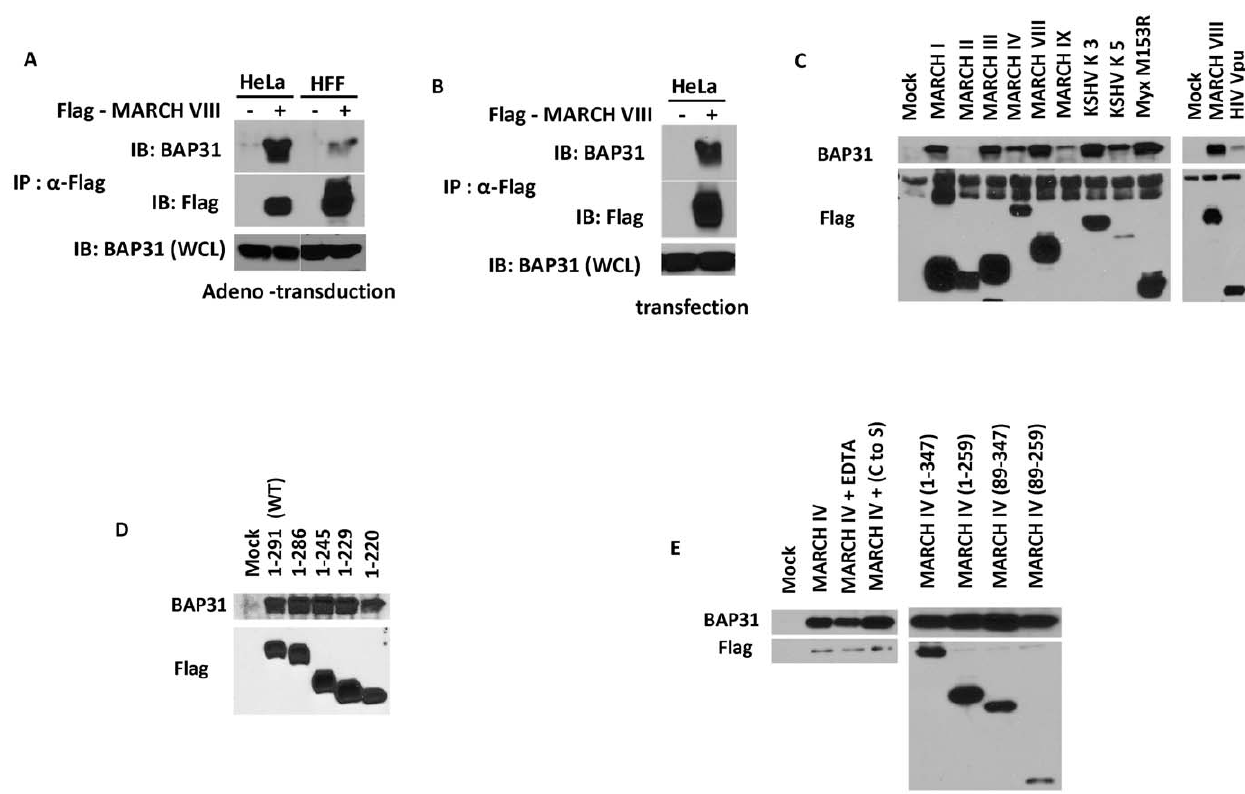
Figure 2. MARCH-VIII interacts with Bap31 through the transmembrane domains. MARCH-VIII C-Flag was expressed in HeLa cells and HFFs using either transfection (A) or adenoviral transduction (B). Cells were lysed in 1% CHAPS and MARCH-VIII was immunoprecipitated using the anti- Flag antibody. Following immunoprecipitation, samples were separated on an SDS-PAGE gel and the presence of Bap31 was analyzed via immunoblot. 5% of each sample was blotted with anti-Flag antibody to confirm MARCH-VIII expression. (C): HeLa cells were transfected with C- terminally Flag tagged versions of each MARCH protein as well as the viral MARCH proteins KSHV-K3, KSHV-K5, MYXV-M153 and the HIV-1 protein Vpu. 24 hours post transfection, each sample was lysed and analyzed as above. Expression of each transfected protein was confirmed by blotting 5% of each immunoprecipitation with the anti-Flag antibody. (D): To determine which region of MARCH proteins was required for interaction with Bap31 we used a series of previously constructed MARCH -VIII truncations. HeLa cells were transfected with C-terminally flag-tagged versions of